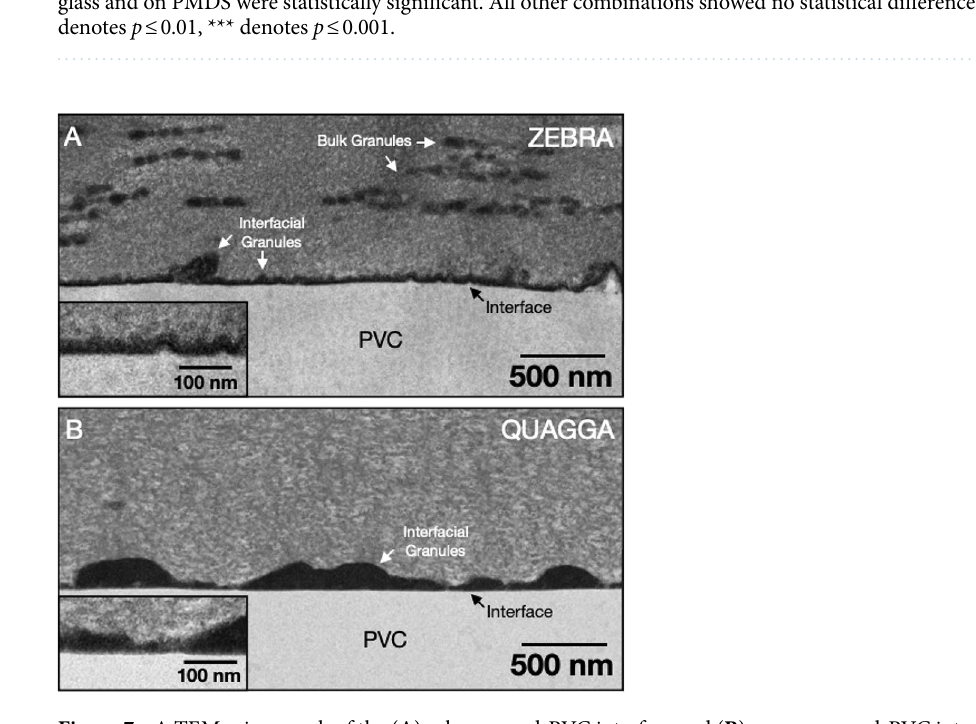
Figure 7. A TEM micrograph of the ( A ) zebra mussel-PVC interface and ( B ) quagga mussel-PVC